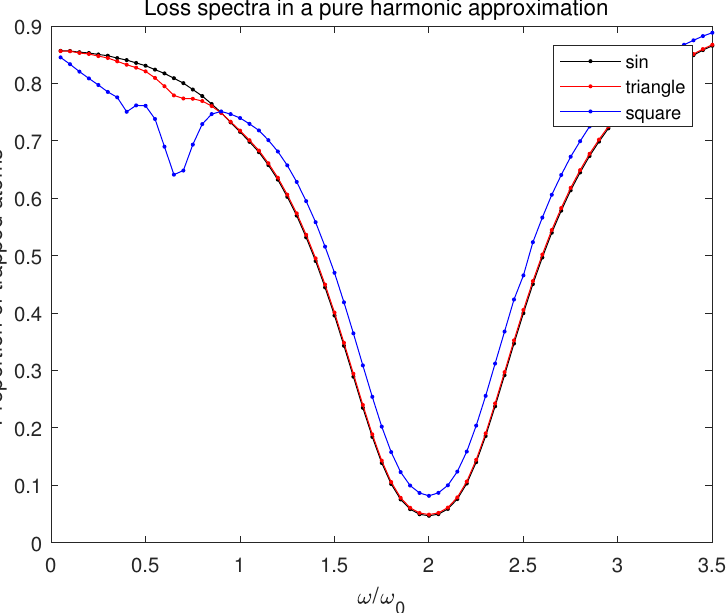
Figure 7. Decimal logarithms of the simulated population of the lowest level vs the relative frequency ω / ω 0 of the modulation signal at the instant t = 50 ms, within the pure harmonic (i.e., with ω 3 = 0) model described above: black—the sinusoidal modulation signal, red—the triangular modulation signal, blue—the square modulation